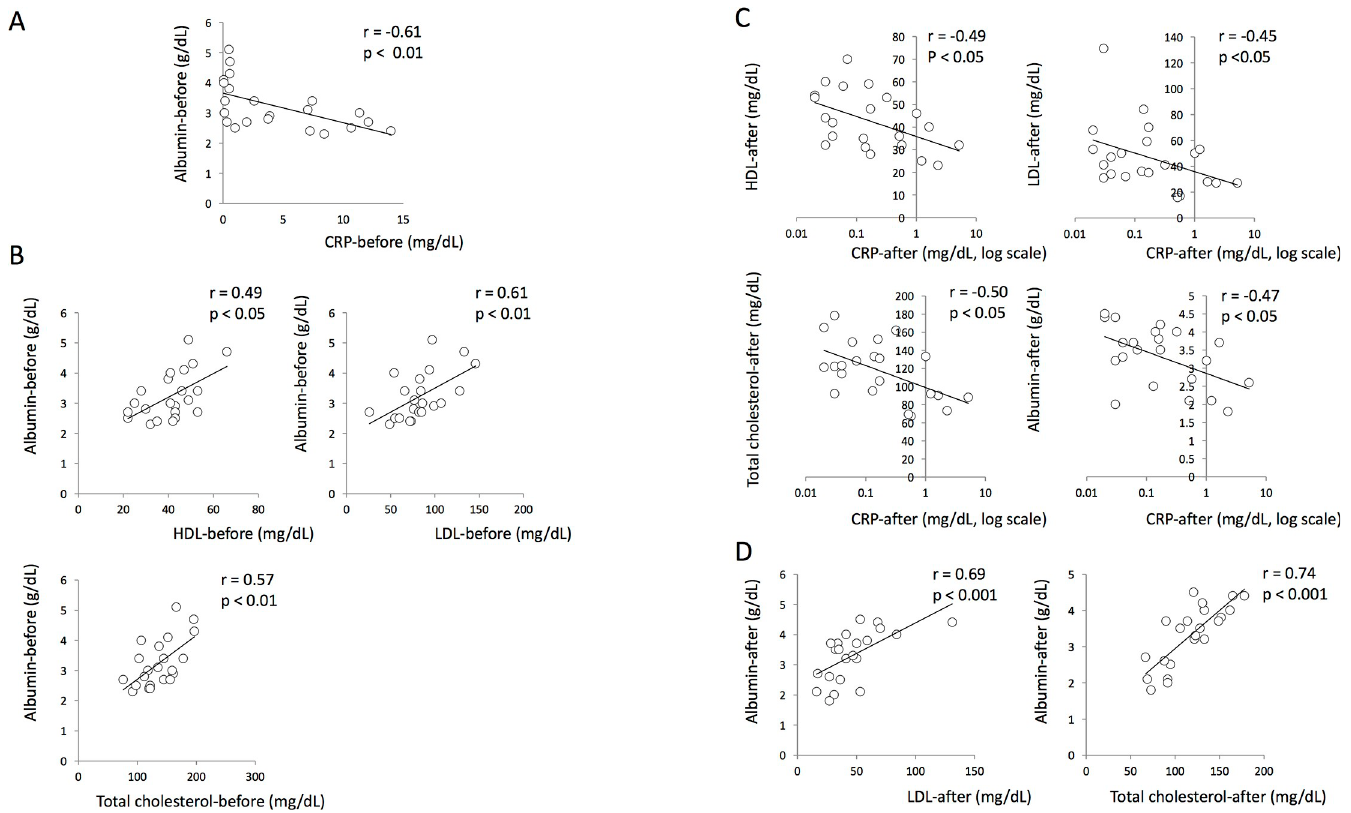
Fig 4. Comparison of CRP and serum nutritional parameters. (A) Correlation between serum CRP level and albumin in active TB patients before treatment. (B) The relationship between serum lipids and serum albumin levels in TB patients at the onset of treatment. (C) The relationship between serum CRP levels and nutritional parameters in TB patients after chemotherapy. (D) The relationship between serum lipid parameters and serum albumin levels in TB patients after chemotherapy.